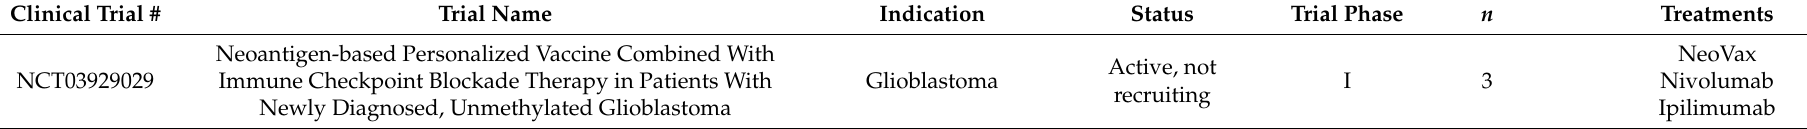
Table 2. Combining multiple checkpoint blockade antibodies with neoantigen